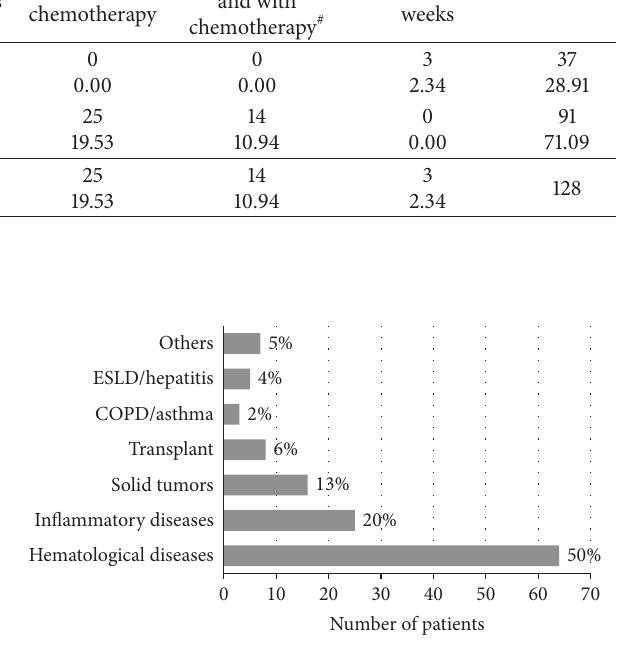
Figure 1: Underlying conditions in non-HIV patients with PCP (COPD: Chronic Obstructive Pulmonary Disease, ESLD: End Stage Liver